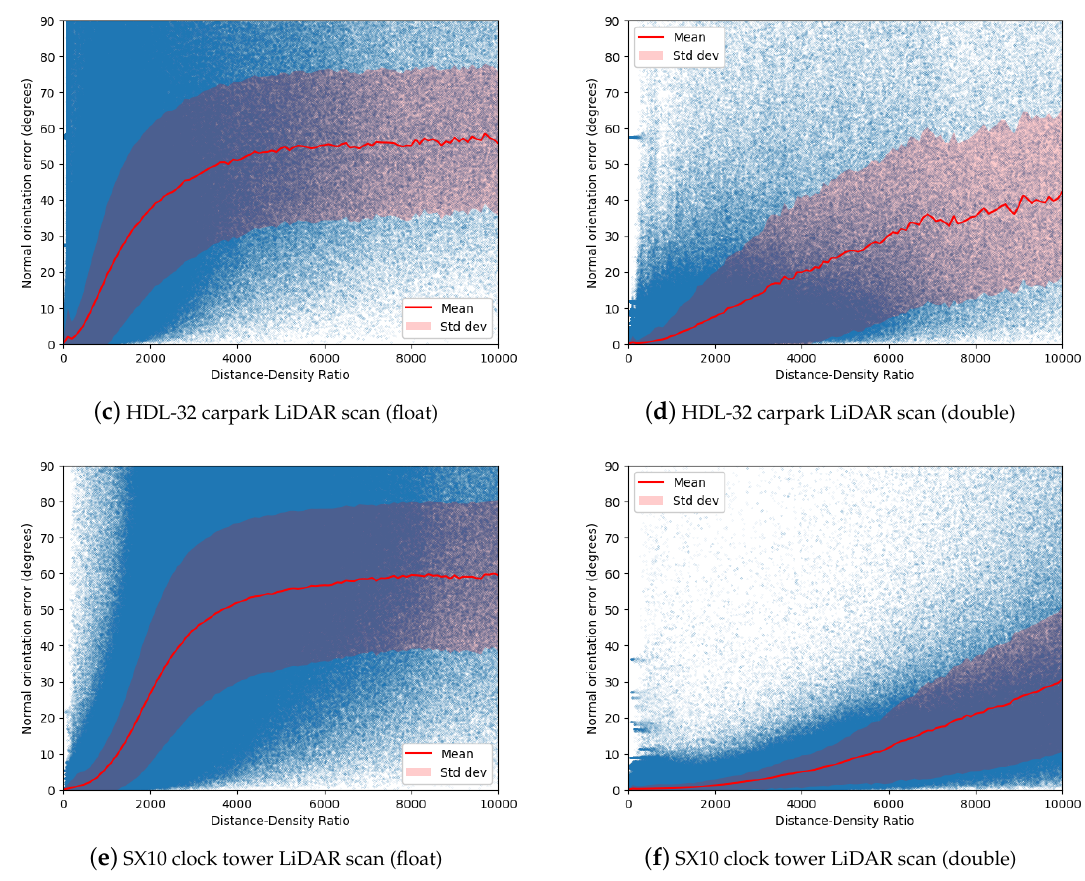
Figure 5. Normal error mean and standard deviation results. Scatter plots illustrate how as the DDR increases, so does the mean normal deviation from the ground truth. Each plot point represents the calculated result of a single cloud point. Plots on the left were generated with the float data type, images on the right with the double data